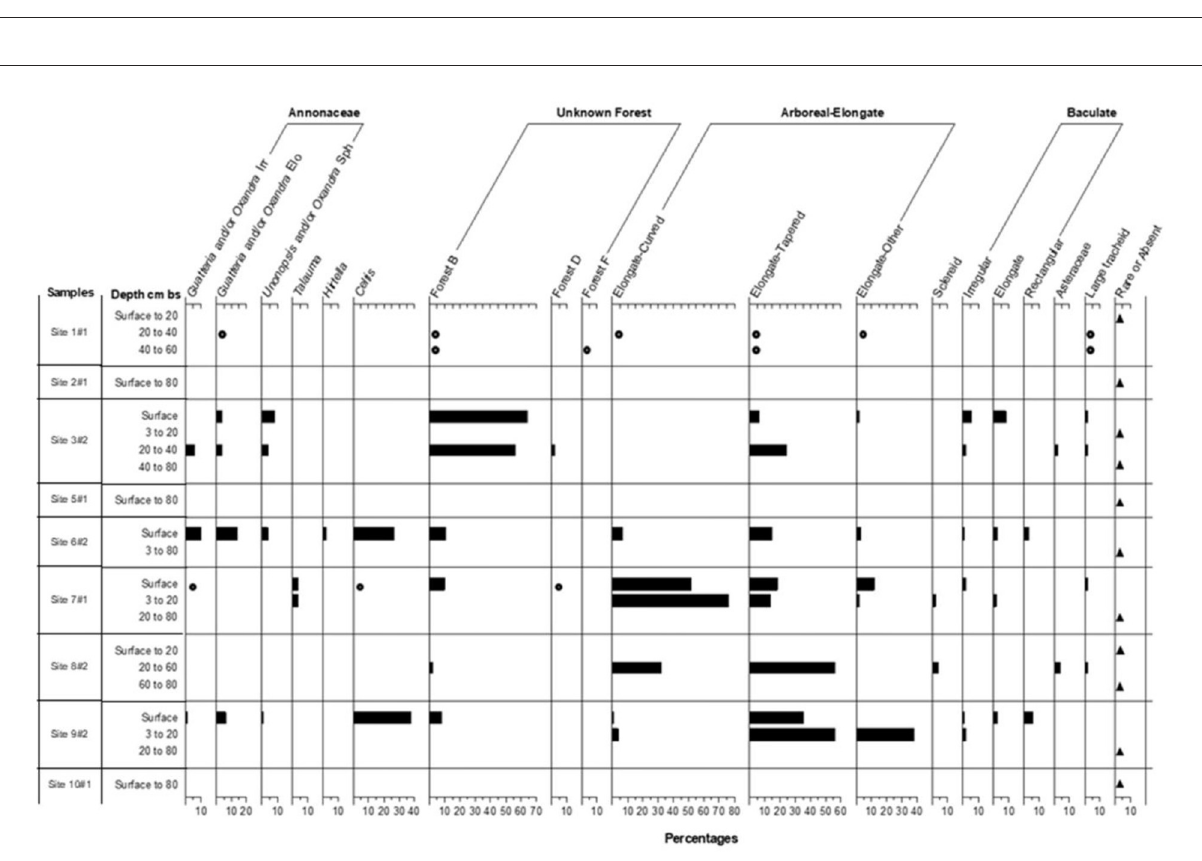
FIGURE4 Percentage frequencies of phytoliths in the silt fractions of the soils at the ten sites. Where quantification occurred from 50 to 100 phytoliths were counted. For samples where counts of at least 50 phytoliths could not be achieved, taxa denoted with a circle.